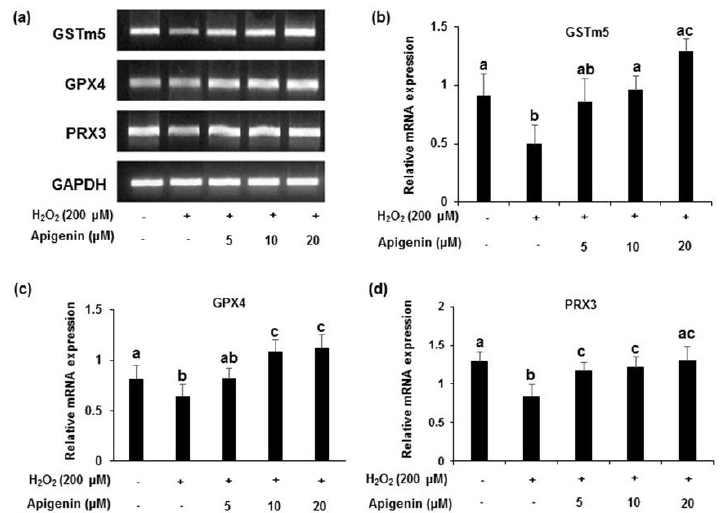
Figure 5. Effects of apigenin on the antioxidant enzyme mRNA expression level in hydrogen peroxide-exposed GC-2spd cells. ( a ) The mRNA expression level of the antioxidant enzymes GSTm5, GPX4 and PRX3 in H 2 O 2 -exposed GC-2spd cells. ( b – d ) The polymerase chain reaction band intensity of GSTm5, GPX4 and PRX3 was analyzed using the ImageJ 1.41o software package and was normalized to that of glyceraldehyde 3-phosphate dehydrogenase. Data are expressed as the mean ± standard deviation. The groups of control, H 2 O 2 , and different concentrations of apigenin were compared with each other and letters on the top of the columns that do not share the same letters are statistically significant among the groups ( p < 0.05) by one-way ANOVA. GSTm5, glutathione S-transferase m5; GPX4, glutathione peroxidase 4; PRX3, peroxiredoxin 3; GAPDH, glyceraldehyde 3-phosphate dehydrogenase.